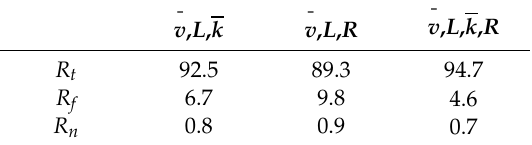
Table 1. Statistical results of track segment association based on di ff erent features